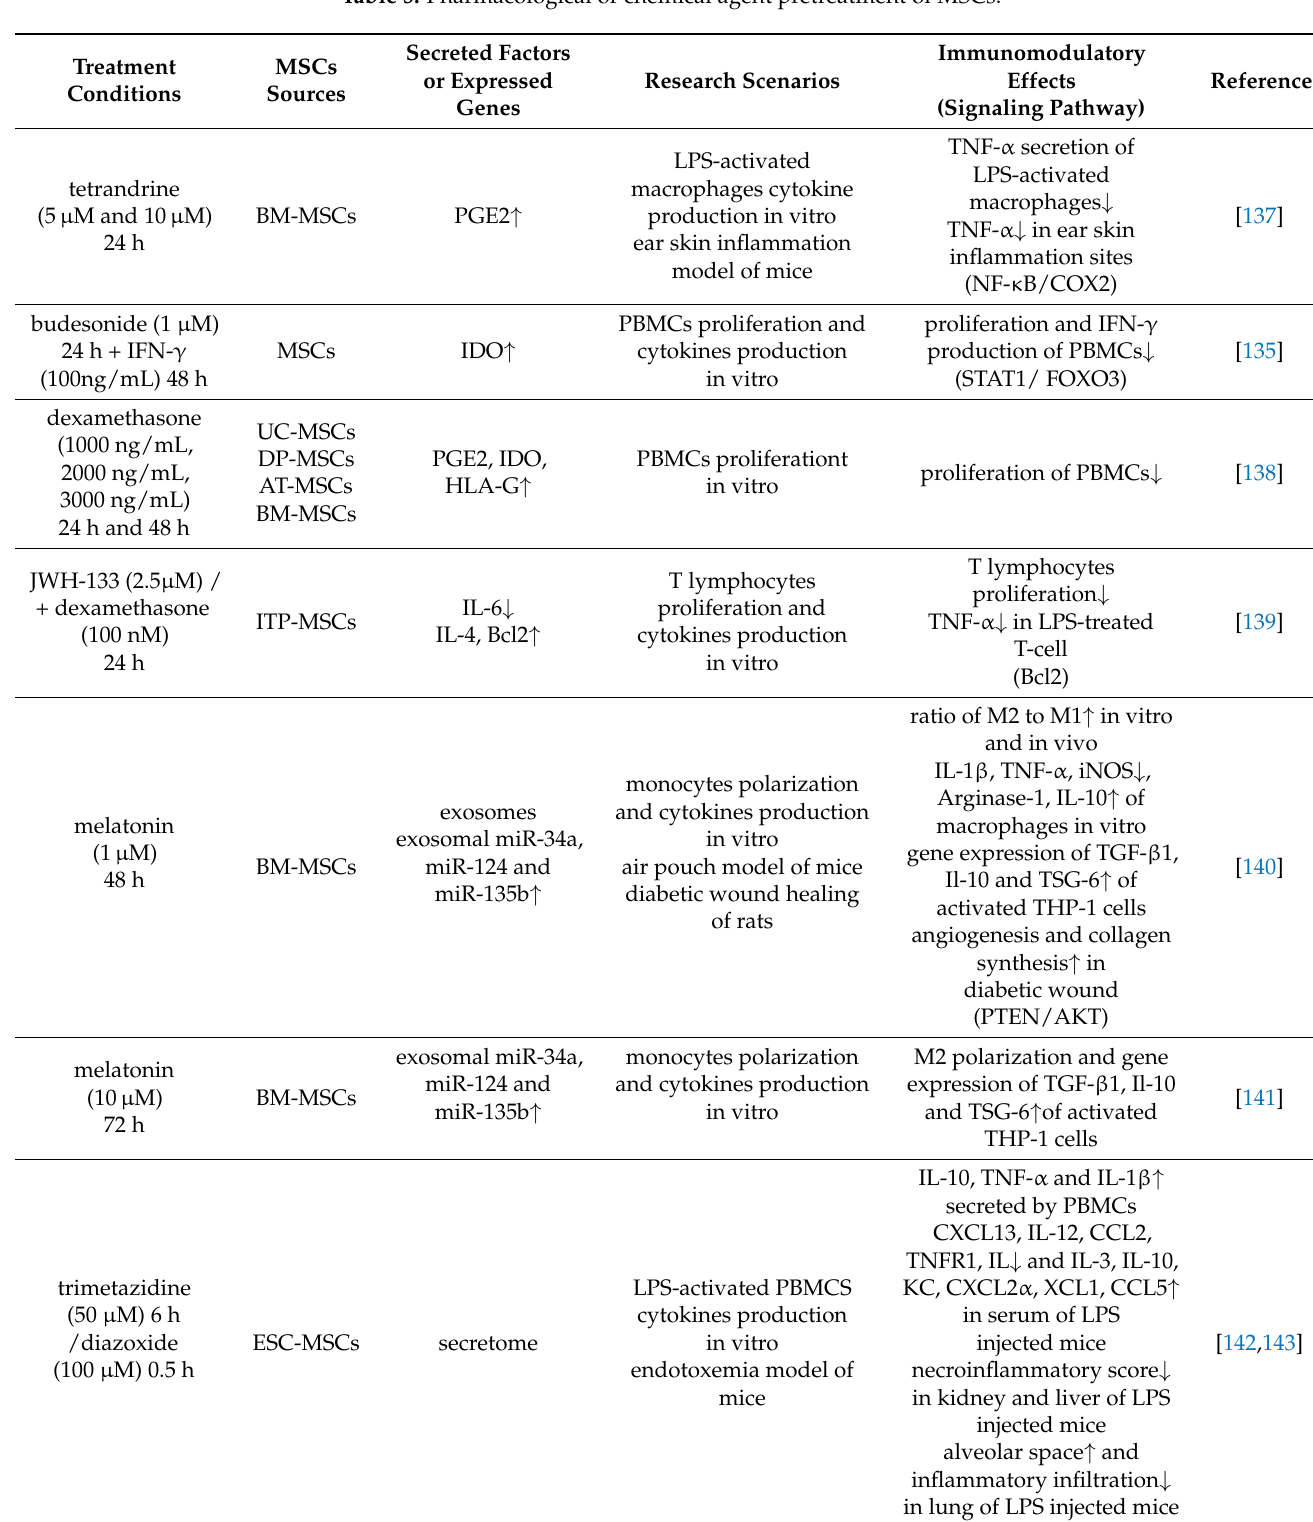
Table 5. Pharmacological or chemical agent pretreatment of